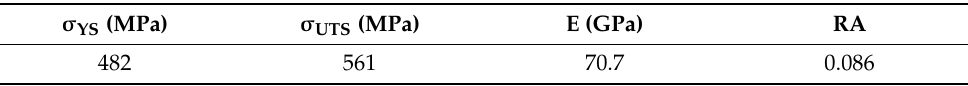
Table 2. Mechanical properties of tested AA7075-T651 material heat along